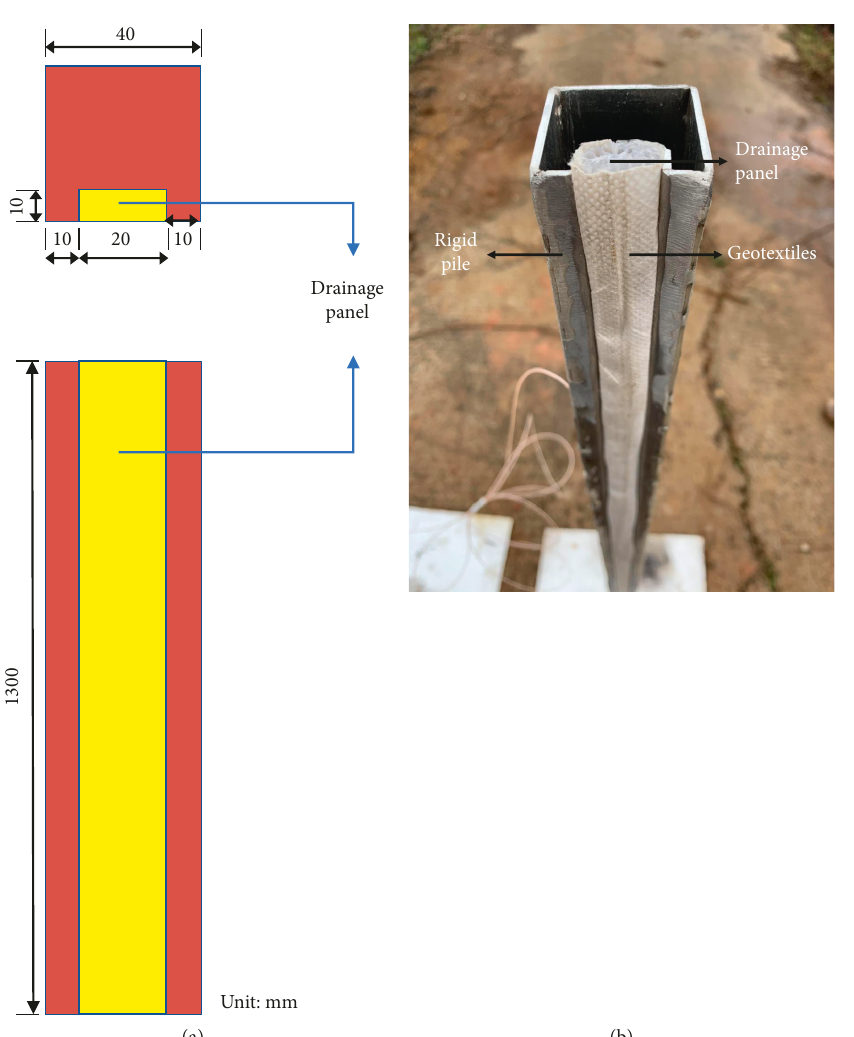
Figure 4: Schematic diagram of drainage rigid pile. (a) Dimensions of the drainage rigid pile. (b) Physical drawing of the drainage rigid